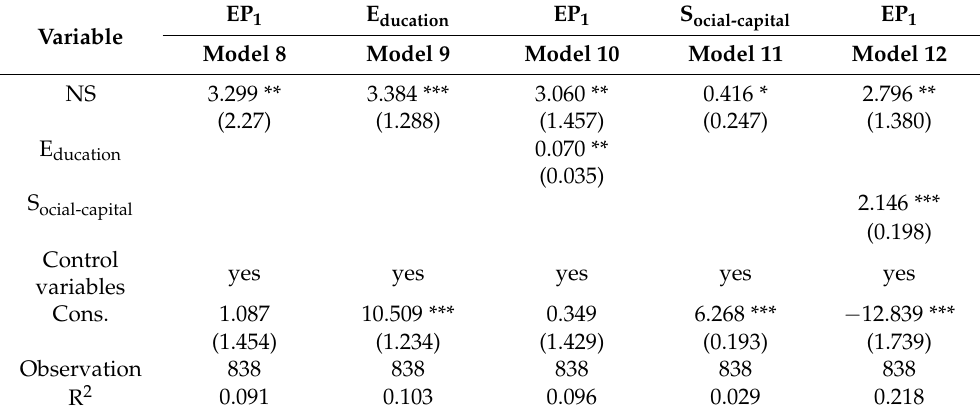
Table 4. Test of intermediary effect of non-cognitive skills influencing farmers’ entrepreneurial